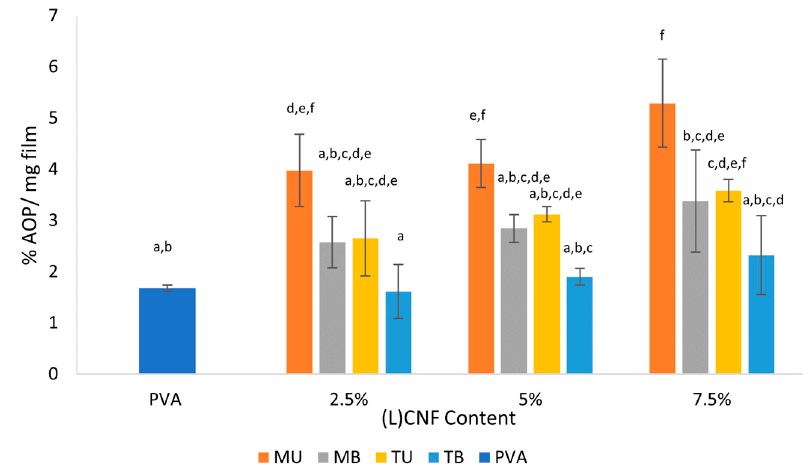
Figure 5. Antioxidant power (AOP) of pure PVA and PVA-(L)CNF films formulated with different concentrations. Different letters above the bars represent groups significantly different at p < 0.05.